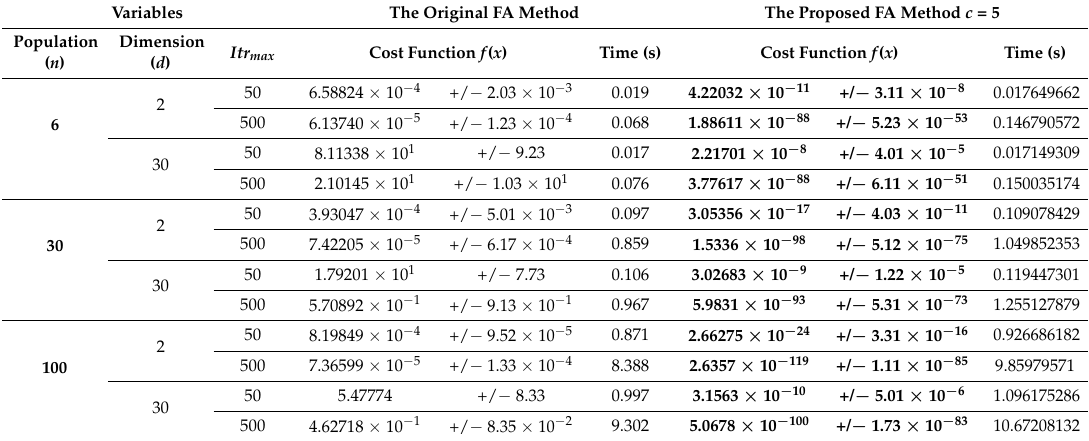
Table 1. Results of the proposed Firefly algorithm (FA) for Schwefel’s Problem. Variables The Original FA Method